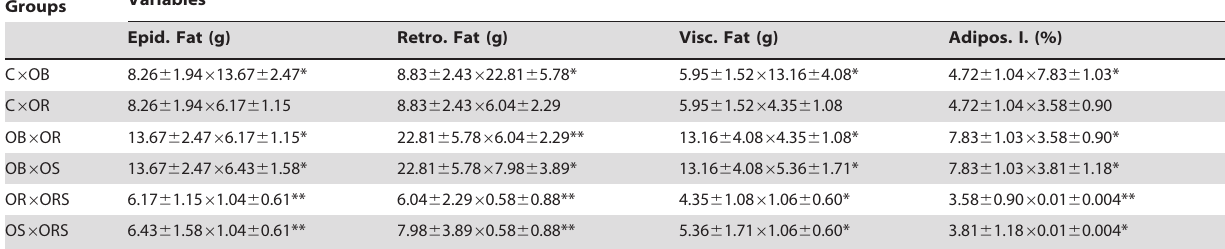
Epid. Fat: epididymal fat; Retro. Fat: retroperitoneal fat; Visc. Fat: visceral fat; total Fat: total body fat; Adipos. I: adiposity index; C. control; OB. obese; OR. calorie- restricted obese; OS: obese with 25 m g T 3 /100 g BW; ORS: calorie-restricted obese rats with 25 m g T 3 /100 g BW. Data expressed as mean 6 standard deviation. ANOVA was utilized, complemented by Bonferroni’s test. *=p , 0.05 and